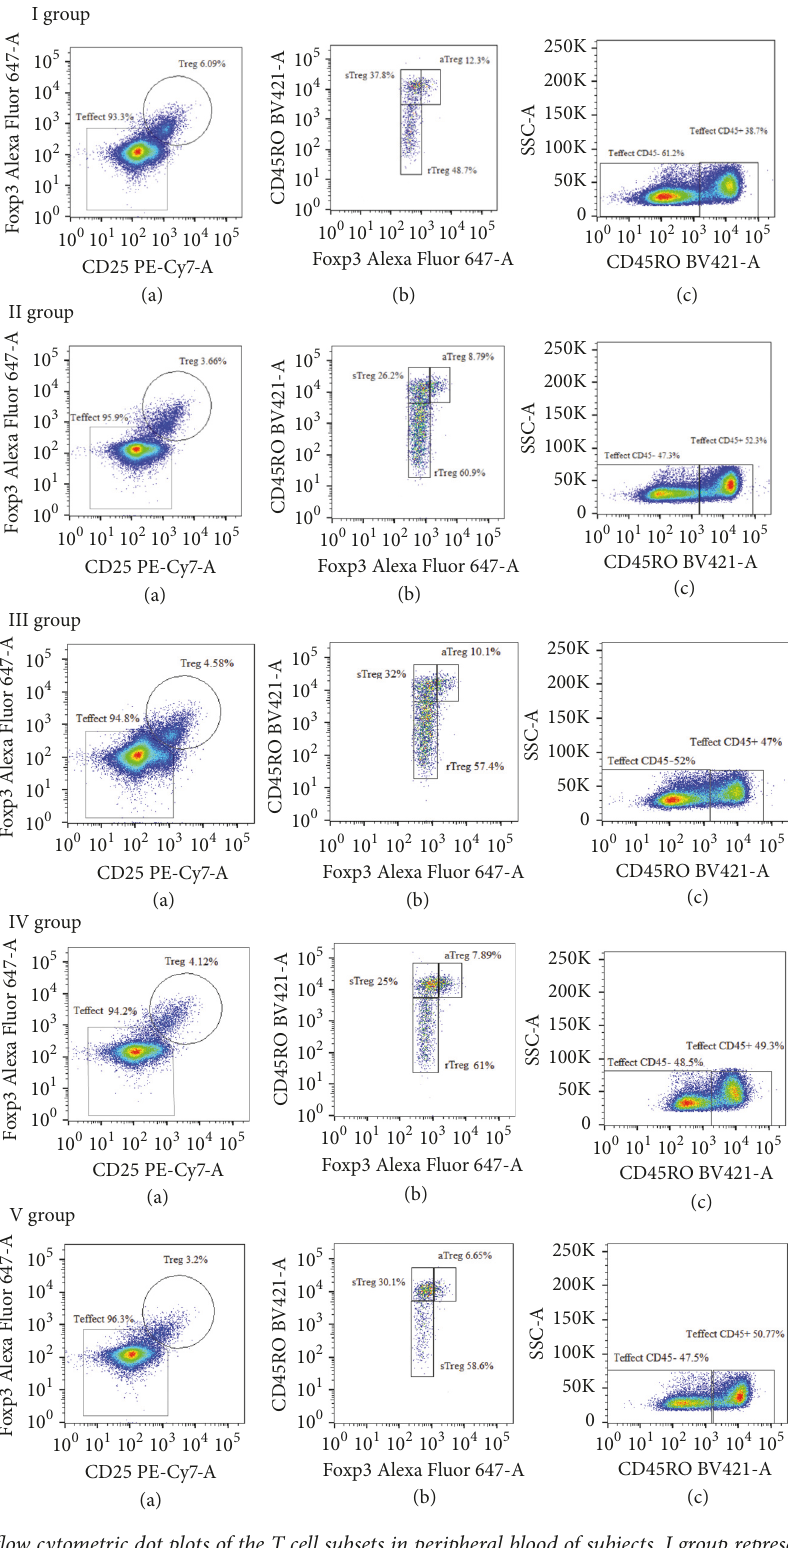
Figure 1: Representative flow cytometric dot plots of the T cell subsets in peripheral blood of subjects. I group represent the healthy controls, II group represent HT patients, III group represent euthyroidism HT, IV group represent subclinical hypothyroidism HT, and V group represent overt hypothyroidism HT. (a) Gating Treg cells (CD25 + Foxp3 + /CD3 + CD4 + T cells), the remainder was regarded as Teffect cells. (b) Treg cells were classified into three subsets, aTreg (CD45RO + Foxp 3 hi ), sTreg (CD45RO + Foxp 3 lo ), and rTreg (CD45RO — Foxp 3 lo ). (c) Teffect cells were divided into two subsets, CD45RO + Teffect and CD45RO −−